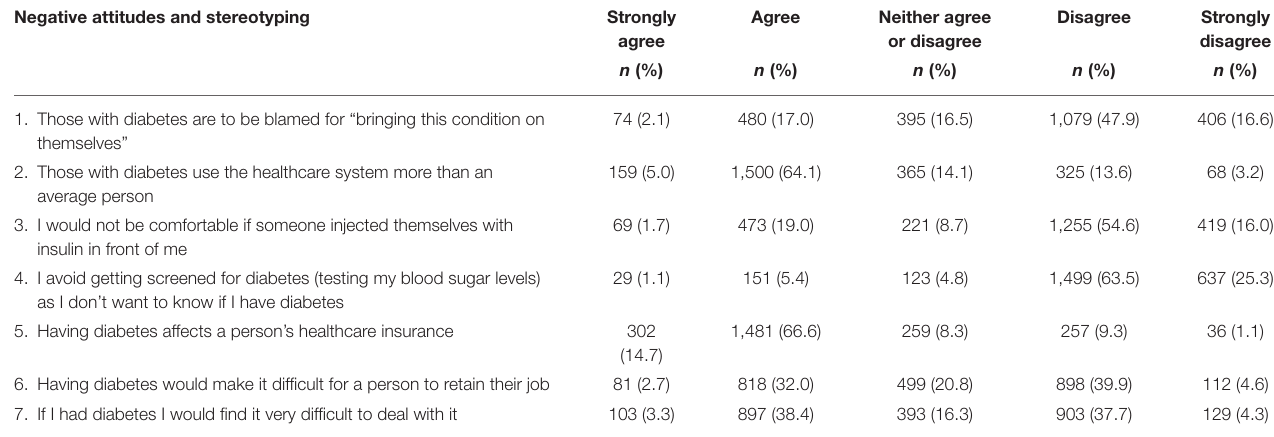
TABLE 2B | Frequency of endorsement of the items of the negative attitudes and stereotyping scale. Negative attitudes and